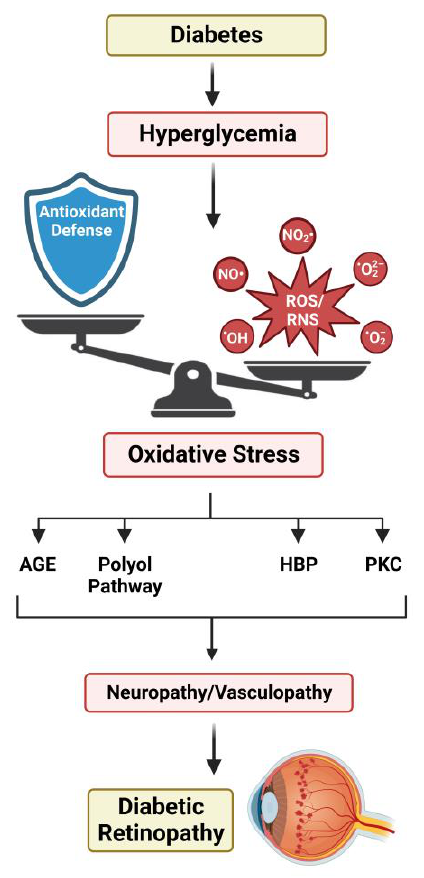
Figure 3. Diabetes-induced hyperglycemia disrupts the redox balance, leading to oxidative stress in the retina. Under normal physiological conditions, there is a balance in the production of reactive oxygen species (ROS)/reactive nitrogen species (RNS) and the antioxidant defense system. Diabetes- induced hyperglycemia promotes ROS/RNS generation while also suppressing the retinal antioxidant response, creating the imbalance known as oxidative stress. The AGE pathway, the polyol pathway, the hexosamine biosynthetic pathway (HBP), and the protein kinase C pathway are all sensitive to this disruption and play an important role in the downstream effects of hyperglycemia-induced retinal damage.